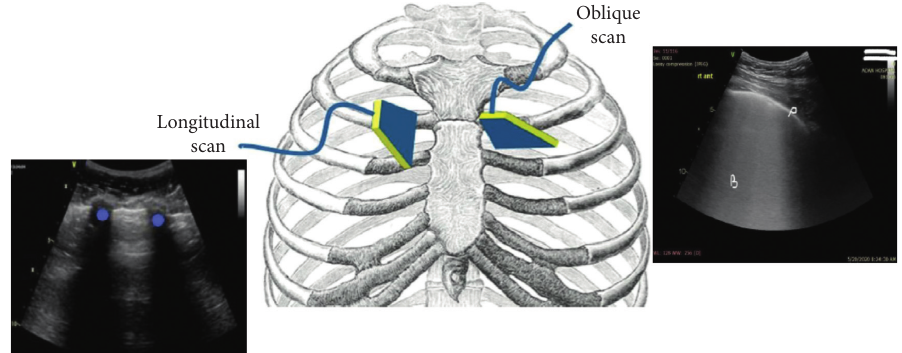
Figure 1: The oblique position of the probe on the intercostal space allows visualization of a larger portion of the pleural line (P) without interruption from the rib shadows (dots) in the longitudinal scan; B, coalesced B-lines.